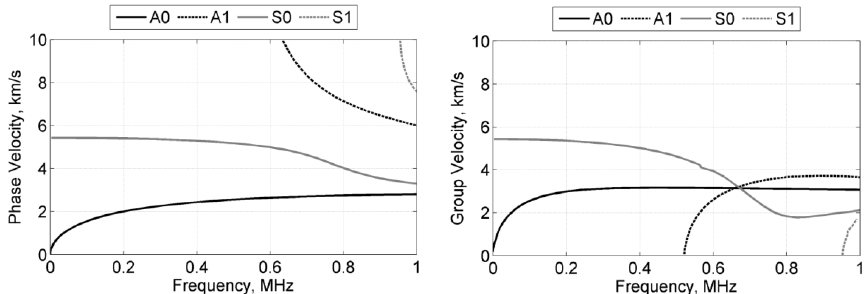
Figure 3. Calculated dispersion curves for a 3 mm aluminium plate, Left: Phase Velocity Right: Group Velocity.